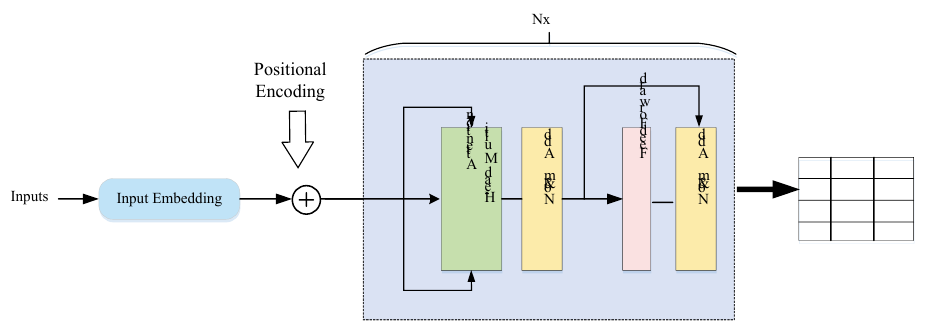
Figure 11. Transformer Encoder.